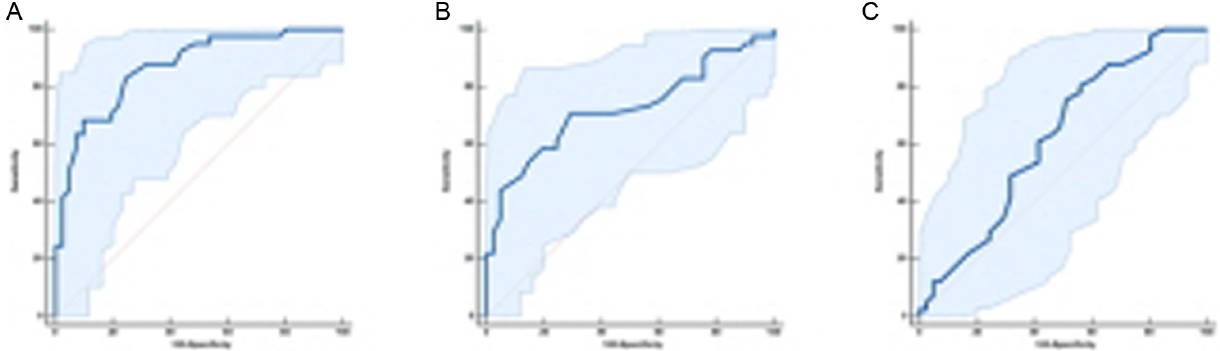
Figure 5. ROC curve demonstrating the predictive performance of color values (A: a *, B: b *, and C: L *) for the cancer in linked color images. ROC, receiver operating